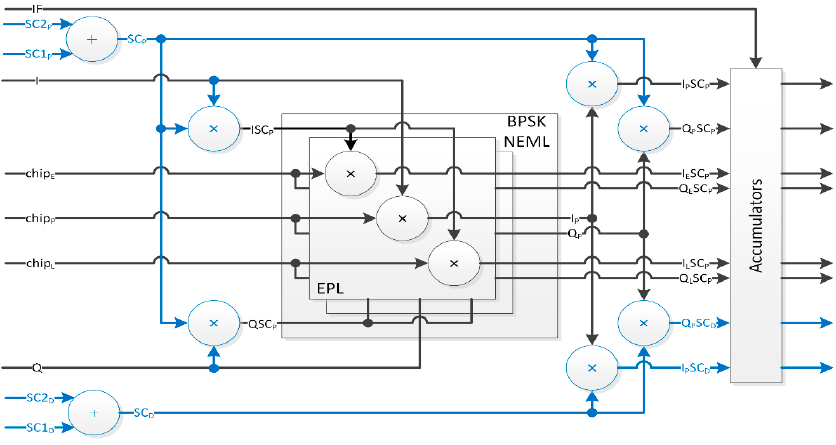
Figure 5. Single-Component Products and Correlation (BPSK vs. MBOC Overhead).